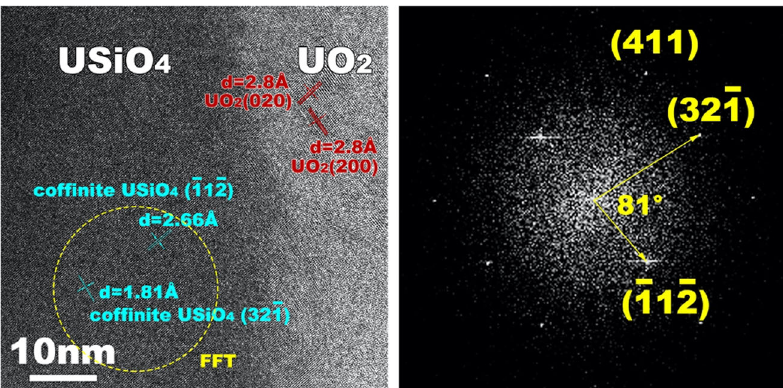
Fig. 3 Characterization of the protective layer formed at the surface of U 3 Si 2 . High-resolution TEM image of the USiO 4 --UO 2 interface (left) and electron diffraction pattern of USiO 4 (right).